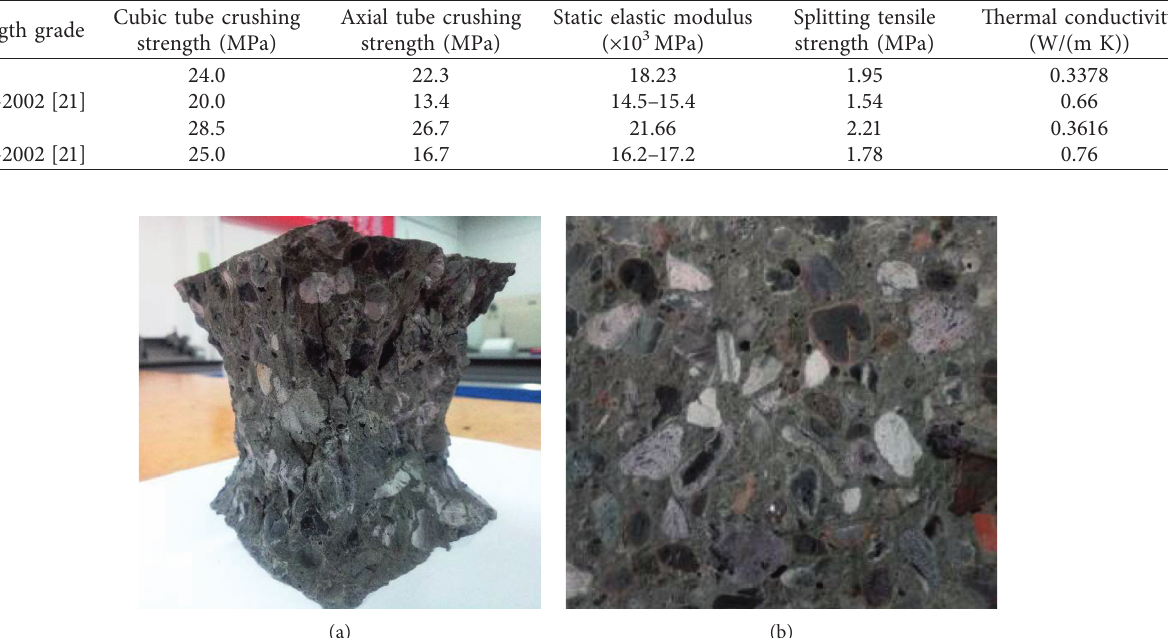
Figure 4: Test results for desert sand lightweight aggregate concrete. (a) Compressive failure mode. (b) Failure